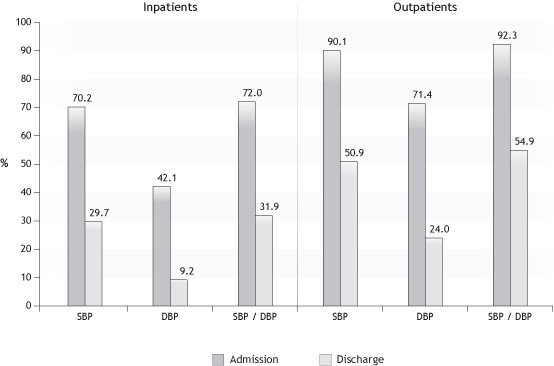
Missed BP goals: Percentages of patients with systolic BP ≥ 140 mmHg and/or diastolic BP ≥ 90 mmHg at discharge. DBP, diastolic blood pressure; SBP, systolic blood pressure.